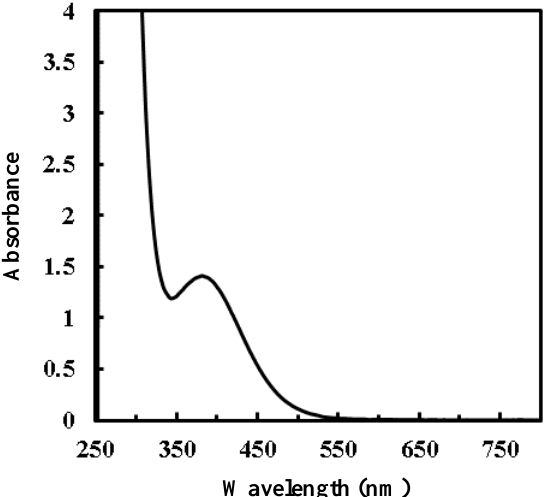
Figure 1. Absorption spectra of diluted solution (Ti 4+ concentration of 0.01 mmol · g − 1 ) of precursor solution S . Ethanol was used as the reference.